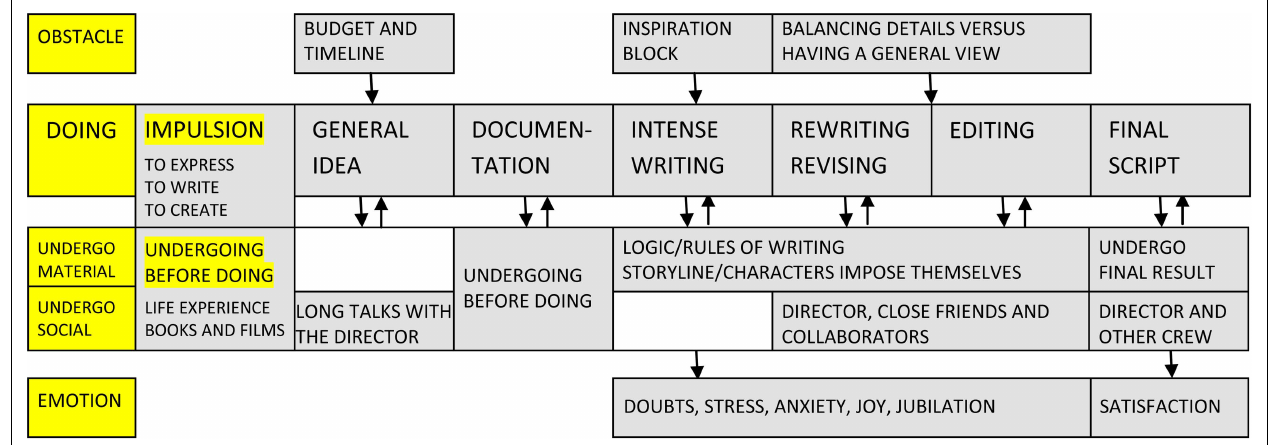
FIGURE 5 | Schematic representation of creative activity in the case of